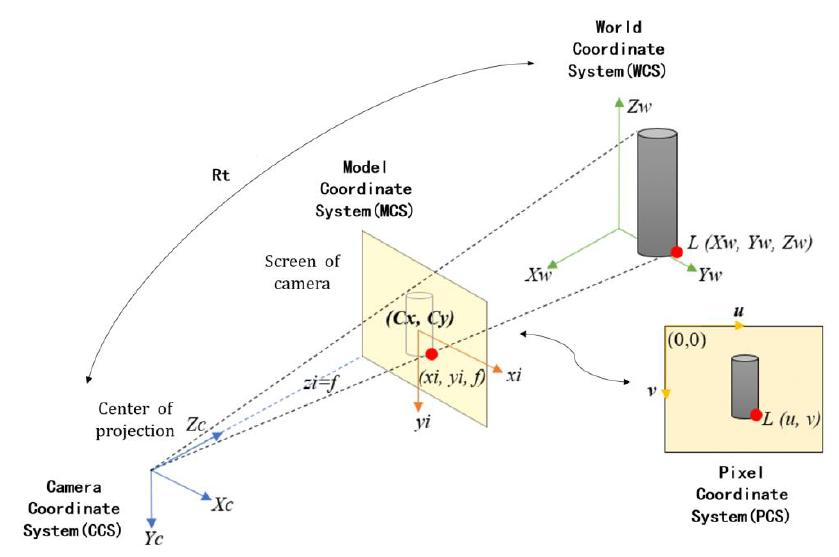
Figure 8. Transformation relationships among the four coordinate systems.